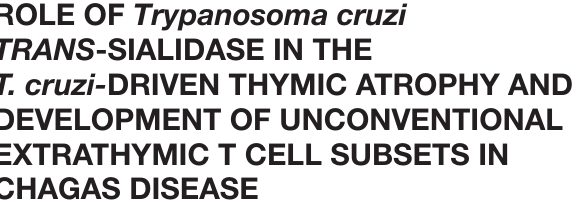
Frontiers in Microbiology |